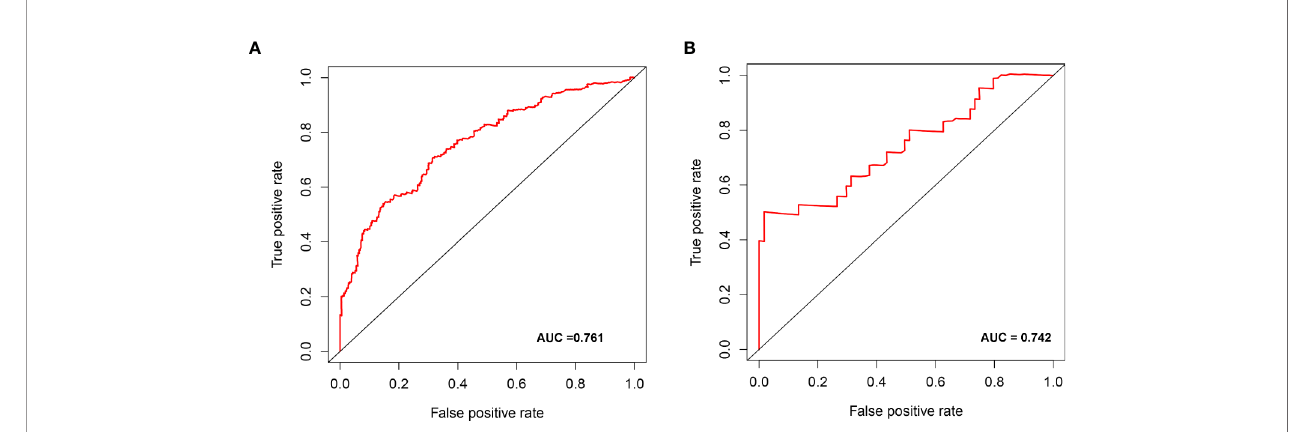
FIGURE 3 | The receive operator curve (ROC) analysis for the EMT-related lncRNA signature in the TCGA dataset (A) and ICGC dataset (B)